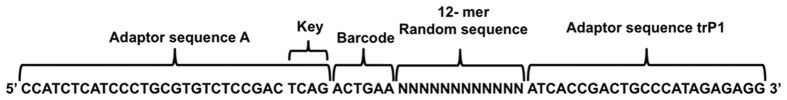
Oligomer template design.The template includes adapter sequences A and trP1 for incorporation into the HTS instrument. Adaptor A includes a “key” for instructing the instrument to begin the read. The adaptors were also used for hybridisation to PCR primers during amplification. The barcode was used for the library identification and was unique for each library. The 12-mer random sequence potentially includes all possible 412 sequences to be screened for TF binding.